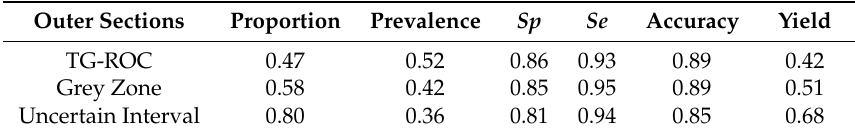
Table 1. Realized results for the outer